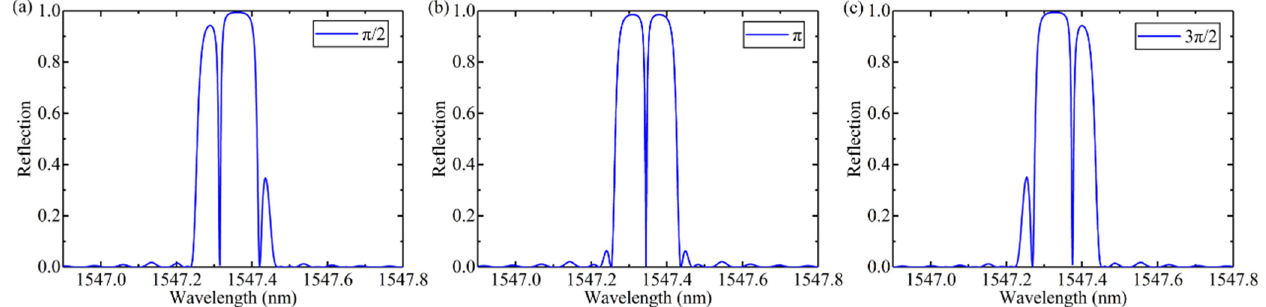
Figure 2. Reflection spectra of FBG ( a ) and phase-shifted FBG for three different values of phase shift ( a ) π /2, ( b ) π , and ( c ) 3 π /2.